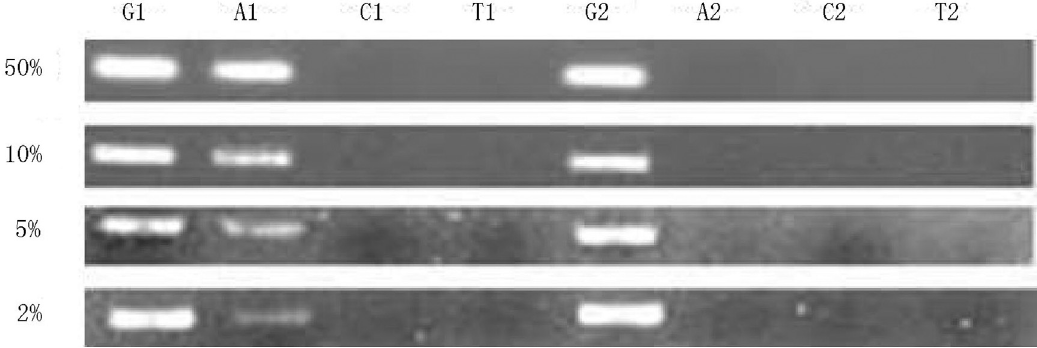
Figure 5 - Sensitivity detection with agarose gel electrophoresis. The proportions of mutated alleles in the total plasmid DNA were 50, 10, 5 and 2%. G, A, C and T represent the four reactions corresponding to each pair of detection